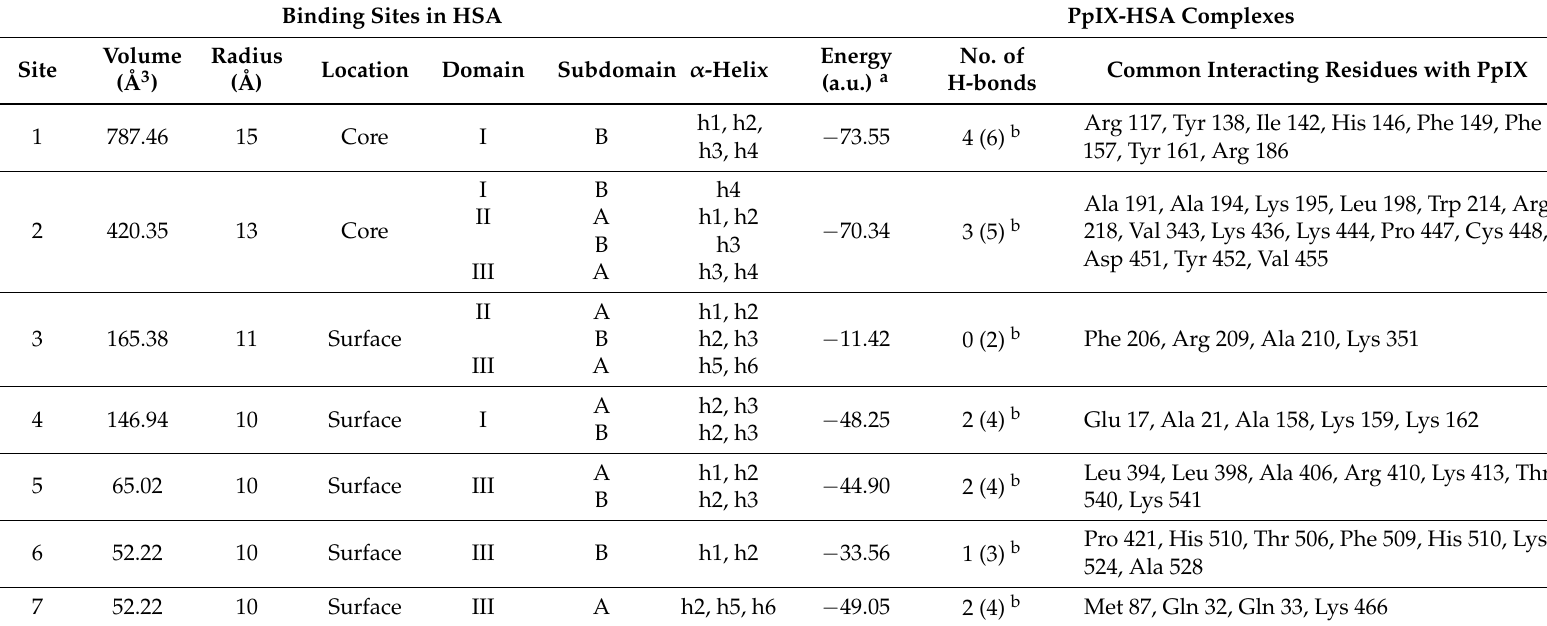
Table 2. Docking results for PpIX molecule inside HSA (1AO6.pdb) showing detailed analysis of the ligand binding sites, protein-ligand interaction energy and major residues involved in hydrogen bonding and hydrophobic interactions. Computational data obtained using the CLC DDWB program [23] and BIOVIA DS Visualizer software